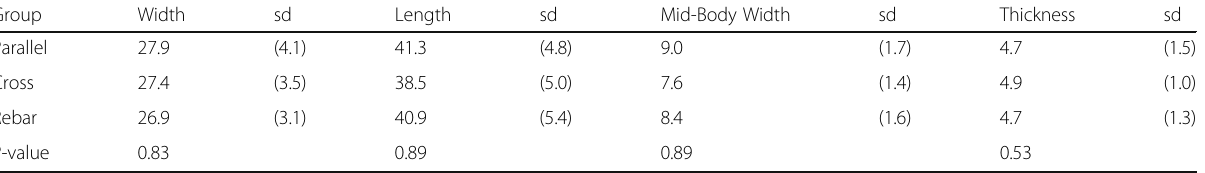
Table 3 Medial Meniscus dimensions (mm) of 3 groups: parallel stitches, Cross Stitch and Rebar Repair Group Width sd Length